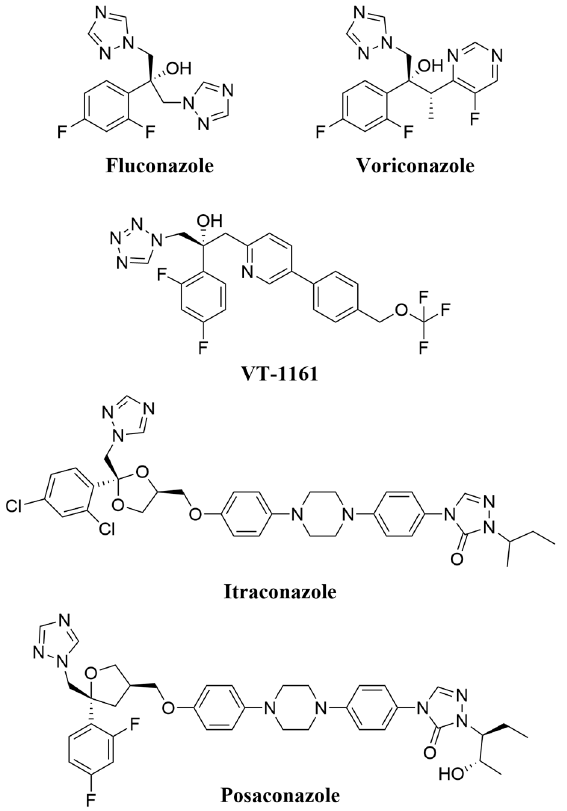
Figure 1. Chemical structures of short- (FLC and VCZ), medium- (VT-1161), and long-tailed (ITC and PCZ) azoles. FLC, VCZ and VT-1161 contain a tertiary alcohol that forms a water-mediated hydrogen bond network to tyrosine 140 in ScLDM6 × His. ITC and PCZ do not contain a comparable hydroxyl